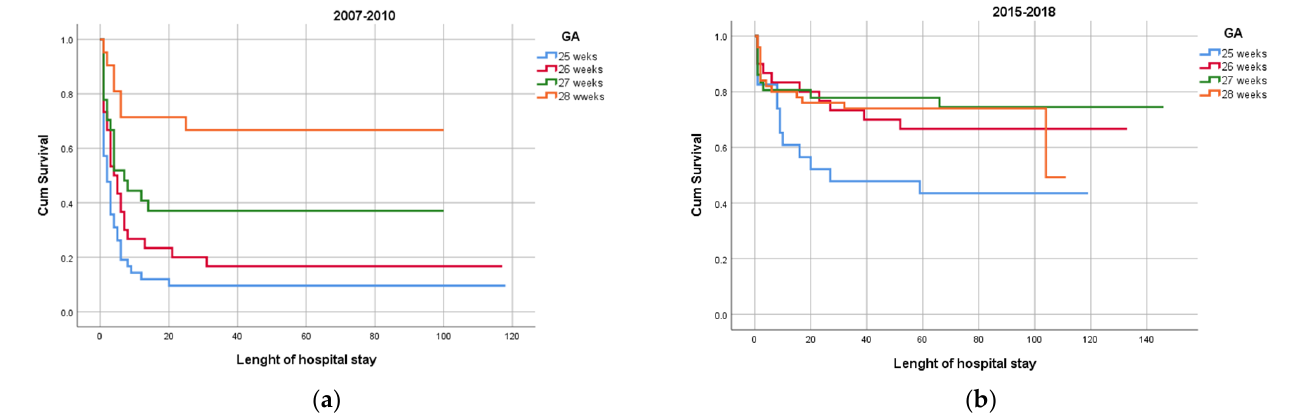
Figure 2. ( a ) Survival to discharge according to gestational age in older cohort and ( b ) newer cohort.